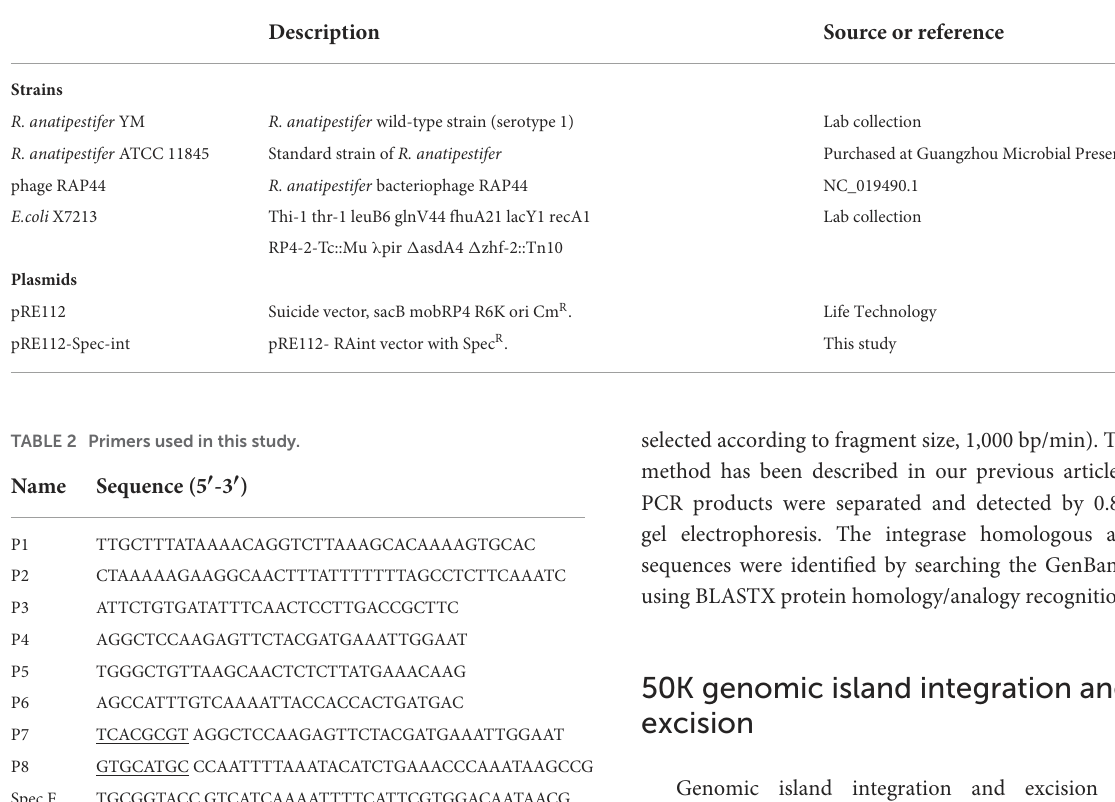
TABLE 1 Bacterial strains and plasmids used in this